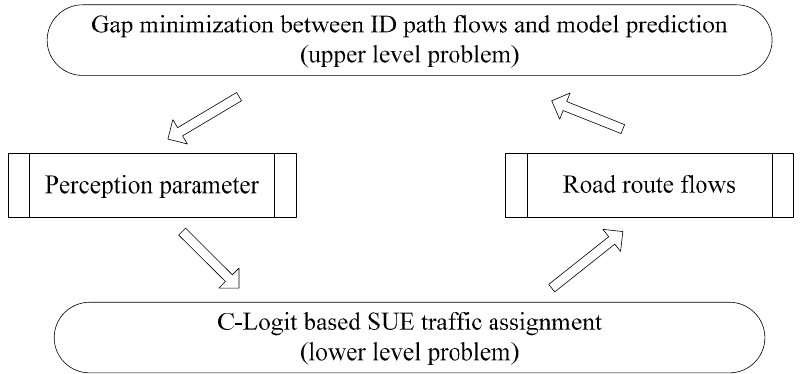
Figure 1. Bilevel interactive process.